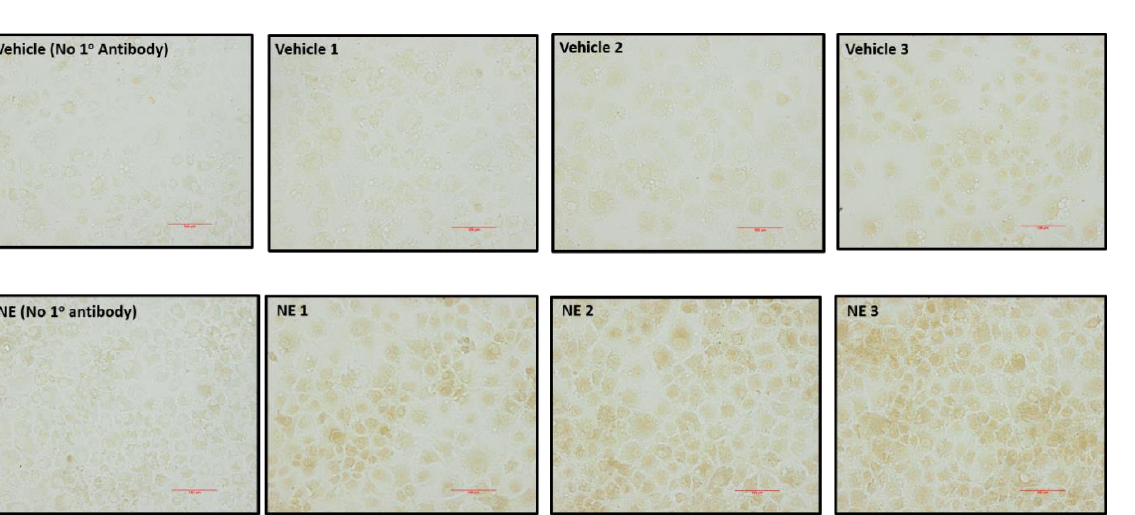
Figure 6. NE (10 μ m) treatment of HK2 cells promoted a significant elevation in IL-6 secretion but did not affect TNF- α secretion. ( A ) TNF- α levels in the supernatant of HK2 cells treated with Vehicle or NE for 24 h; data represented as mean ± SEM; n = 5/group. ( B ) IL-6 levels in the supernatant of HK2 cells treated with Vehicle or NE for 24 h; data represented as mean ± SEM; n = 5 – 6/group; * p = 0.0065. 3.6. Hyper IL-6 Is Bioactive in HK2 Cells and Promotes Increased SGLT1 Expression As conditions involving hyperactivation of the SNS such as type 2 diabetes (T2D) and hypertension display increased levels of IL-6 and its soluble IL-6 receptor (sIL-6R) [14,16,17], we utilised the IL-6 and sIL-R fusion protein, hyper IL-6. All cells express GP130 which is necessary for IL-6/sIL-6R signalling. Concentrations of 100 ng/mL and above were bioactive in HK2 cells as evidenced by increased STAT-3 phosphorylation (Figure 7).